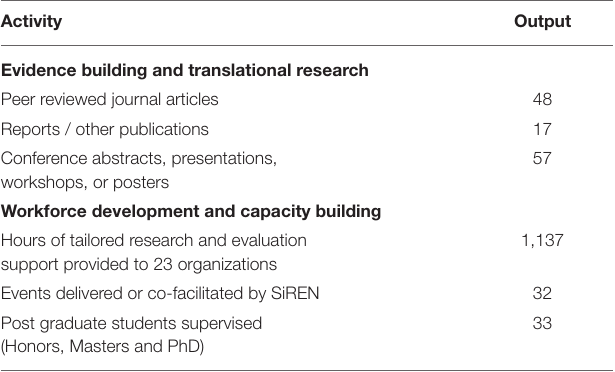
TABLE 4 | Summary of SiREN’s evidence and capacity building outputs from 2012 to